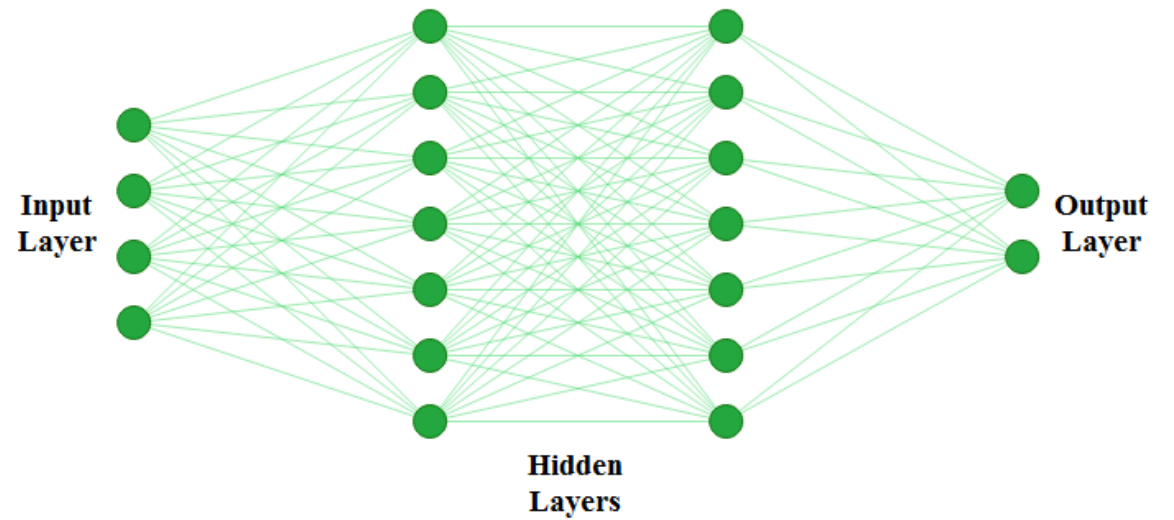
Figure 7. Basic structure of ANN. ANNs are generally defined as having three different layers; an input layer, hidden layer, and output layer. The input layer reads in data values from the user. There can be multiple hidden layers where actual learning takes place, and finally there is an output layer which presents the final result of the